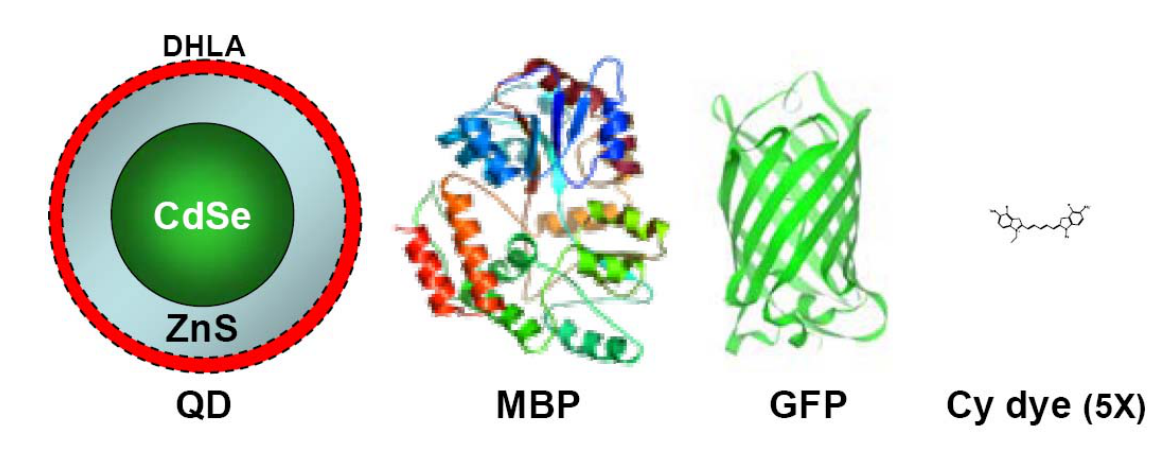
Figure 2. Comparison of the size of a representative dihydrolipoic acid (DHLA) capped CdSe/ZnS QD (550 nm emission and diameter ~ 6 nm), to a maltose binding protein (MBP) molecule (mw~ 44,000), green fluorescent protein (GFP, mw~30,000) and a cyanine dye (Cy, mw~700). Reproduced from